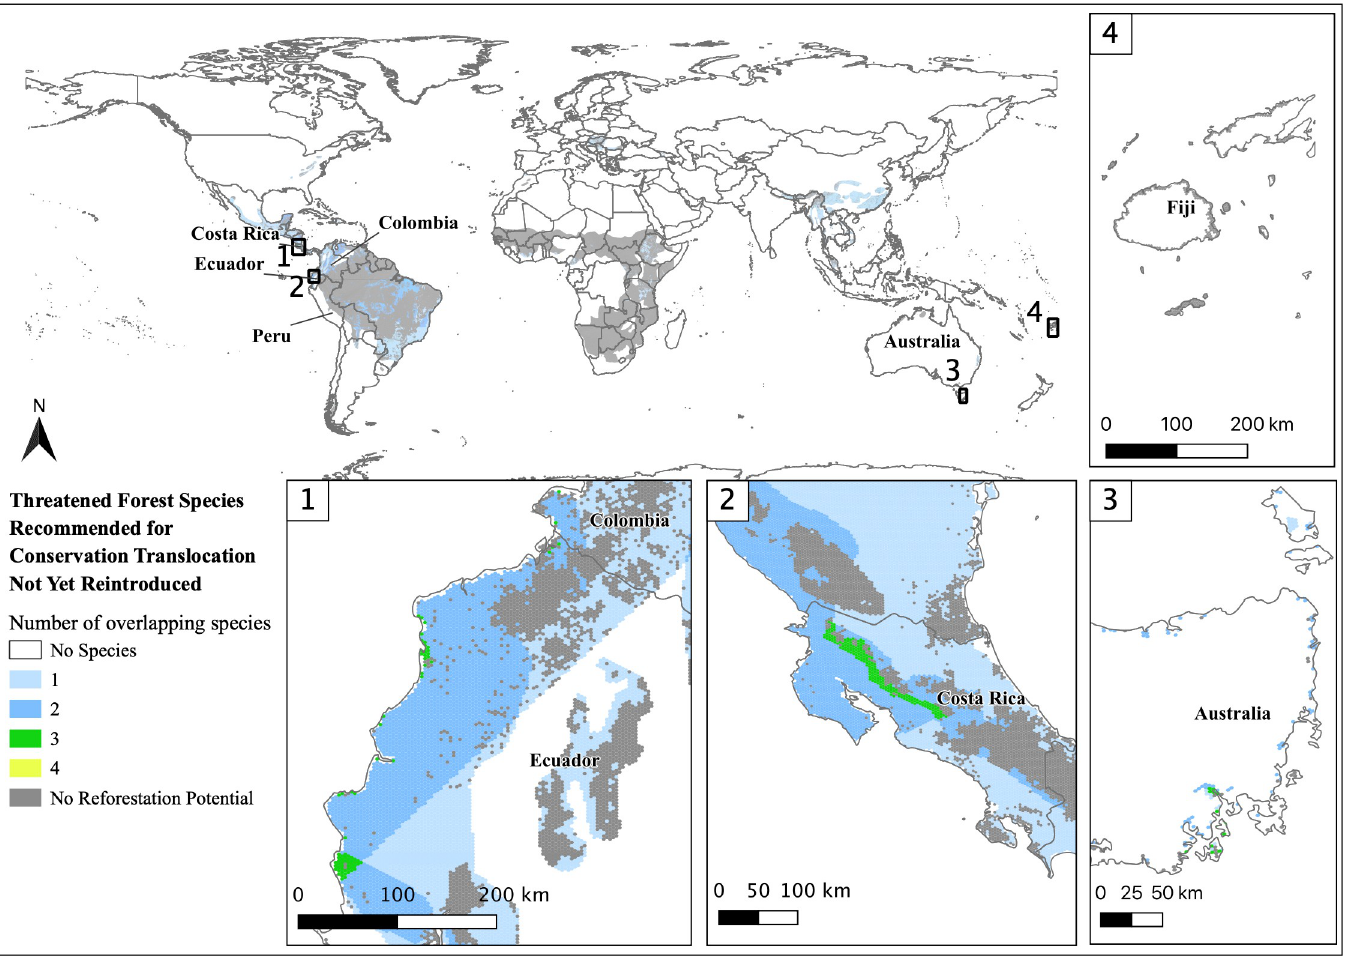
Fig 5. Overlapping species range maps with restoration potential for 68 threatened and Near Threatened terrestrial species, amphibians, birds, mammals, that live in forest habitat without a CT program in-place. Areas in grey indicate where restoration species’ home ranges exist, but there is no potential for habitat restoration. White areas indicate where no species with recommended CT occur. Reprinted partially from the Environmental Systems Research Institute (ESRI) under a CC BY license, with permission from ESRI, original copyright 2021.